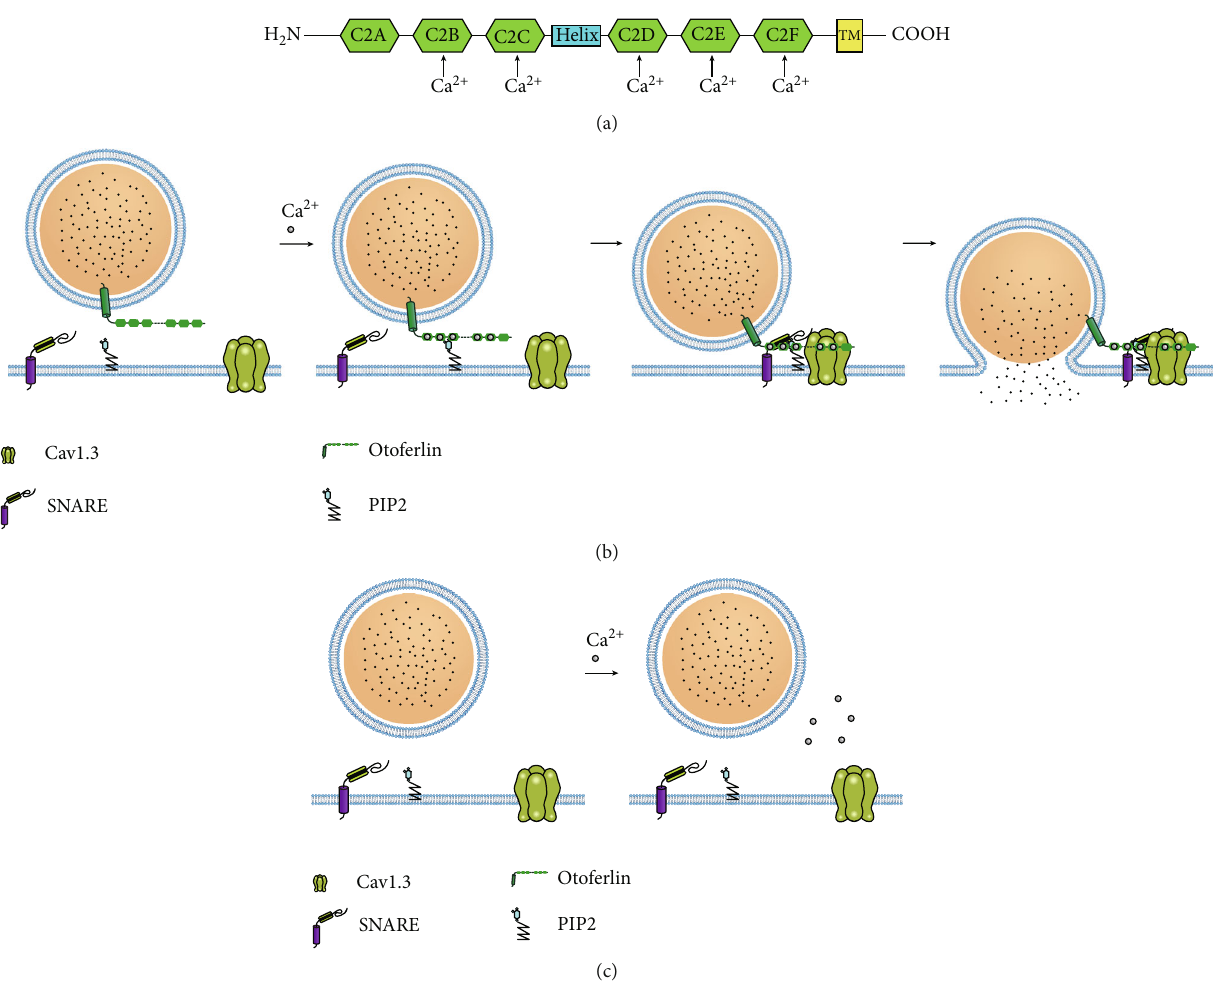
Figure 2: Schematic of the structure and function of Otoferlin. (a) Diagram of Otoferlin depicting the six C2 domains, labeled C2A – C2F, and the transmembrane domain (TMD). The binding of Ca 2+ is indicated for all C2 domains with the exception of C2A. (b) The function of Otoferlin in vesicle fusion. (i) Ca 2+ -dependent phospholipid binding targets the presynaptic membrane via interaction with PIP2. (ii) Ca 2+ -dependent approximation of vesicular and plasma membranes. (iii) Interaction with proteins such as SNARE and the Cav1.3 channels to mediate Ca 2+ -triggered fusion. (c) Loss of Otoferlin. The extracellular transport of synaptic vesicles in the IHCs ceases